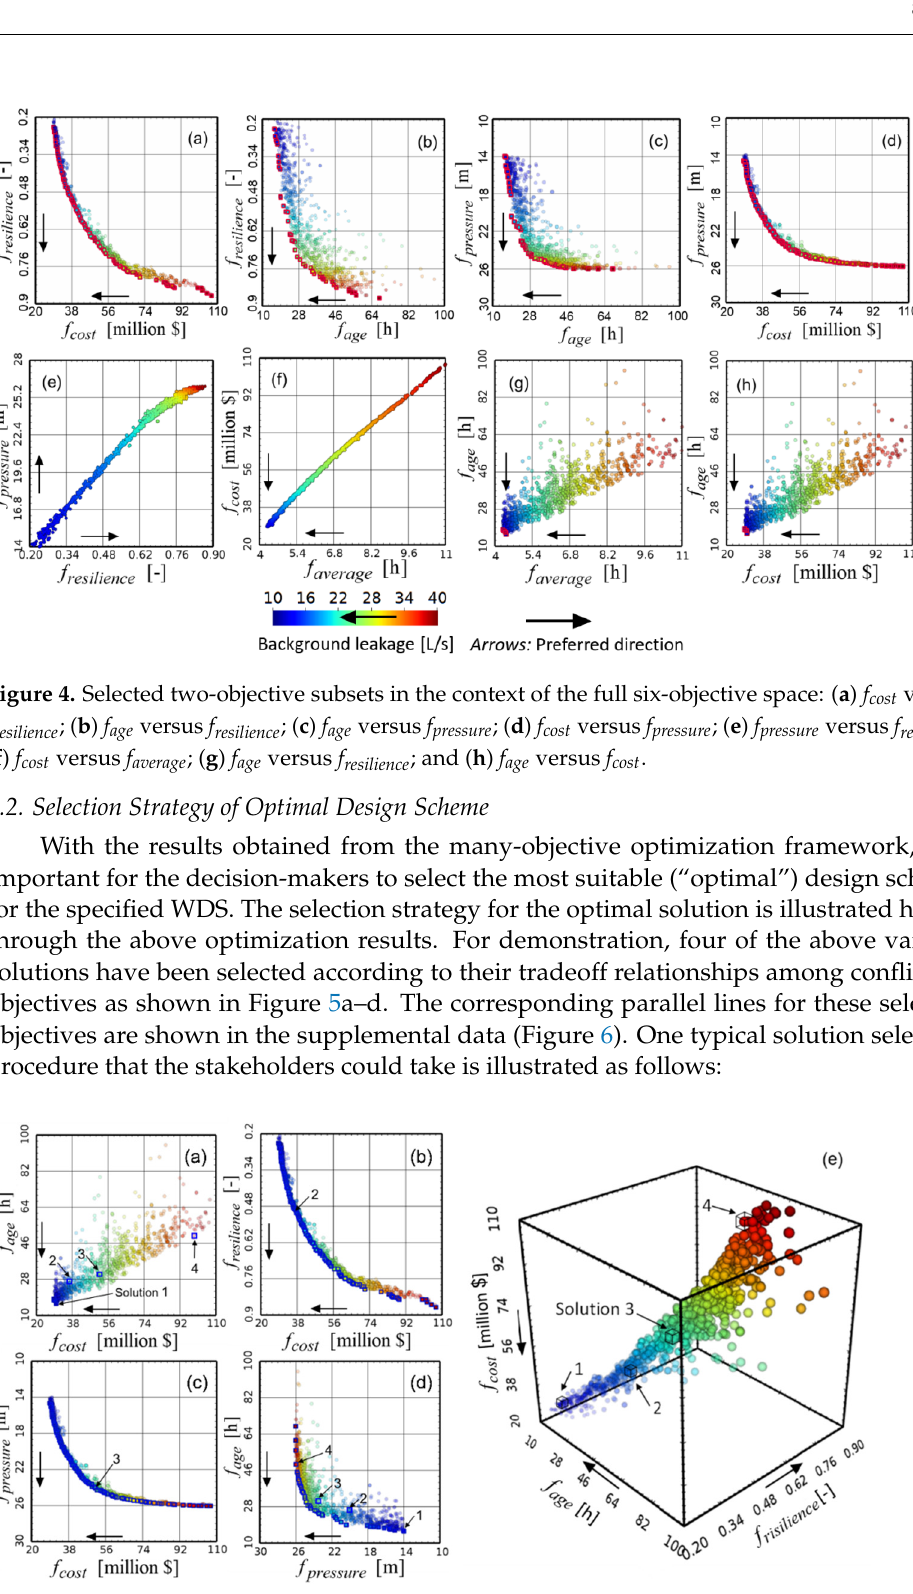
Figure 5. Four representative solutions identified based on a two-dimensional tradeoff: ( a ) f age versus f cost ; ( b ) f cost versus f resilience ; ( c ) f cost versus f pressure ; ( d ) f age versus f pressure , and ( e ) global view.